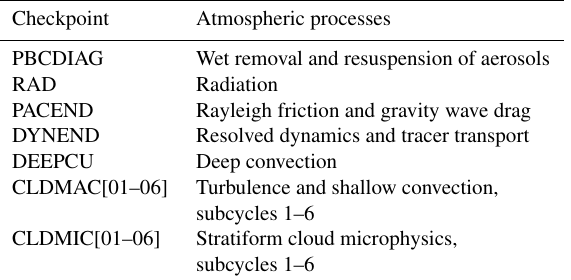
Table 5. For the conditional RHI budget example presented in Sect. 6.3: atmospheric processes corresponding to increments di- agnosed at the checkpoints selected in Table